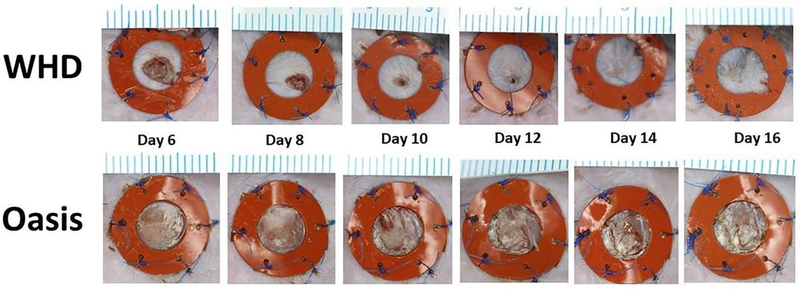
Gross images of full thickness splinted wounds in a diabetic murine model. Days 6–16 of healing demonstrate accelerated wound closure in the WHD treatment group compared to the Oasis Matrix Scale: each line = 1 mm.